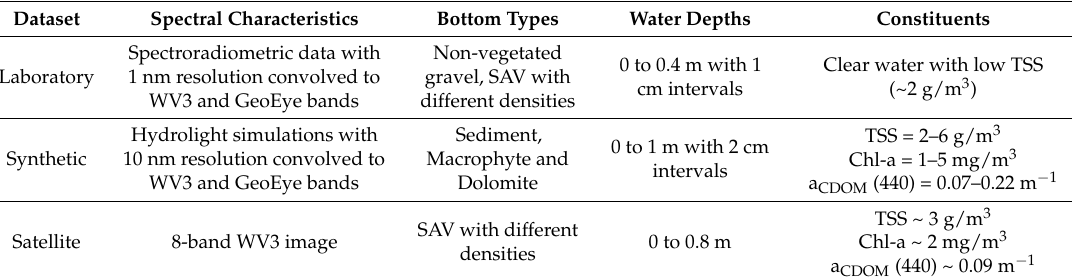
Table 2. Datasets used in this study and their